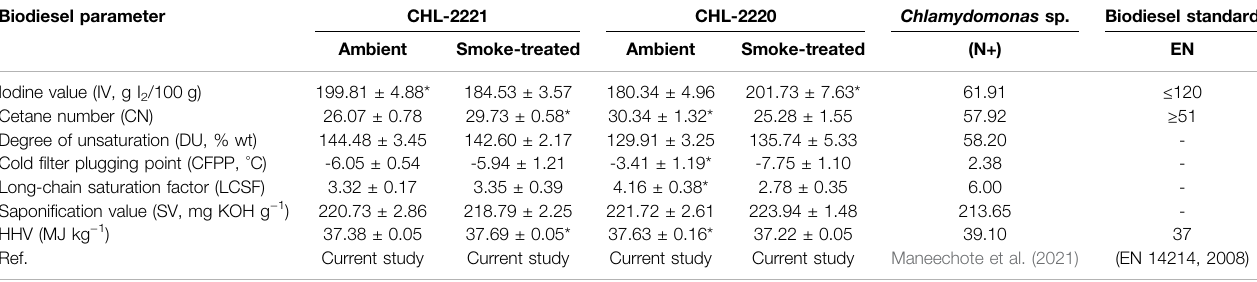
TABLE 2 | Biodiesel parameters of CHL-2221 and CHL-2220 in response to ambient air and tobacco smoke exposure. Biodiesel